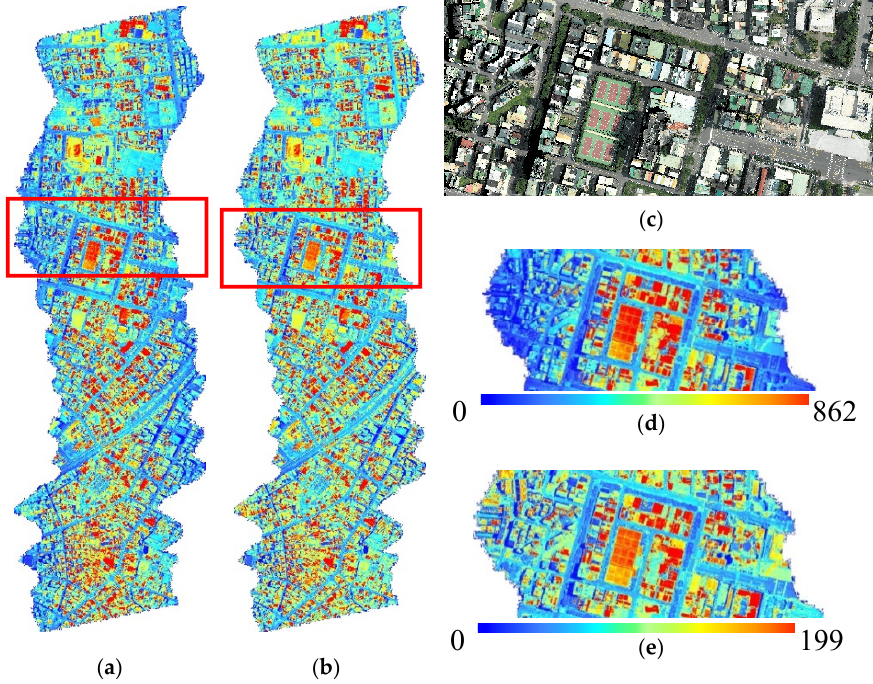
Figure 4. Illustration of intensity correction: ( a ) original intensity; ( b ) corrected intensity; ( c ) reference image; ( d ) enlargement of original intensity; and ( e ) enlargement of corrected intensity.